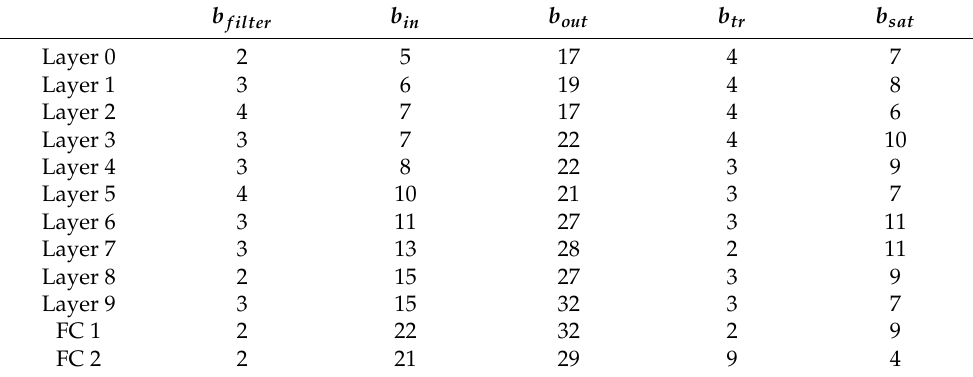
Table 1. Network quantization